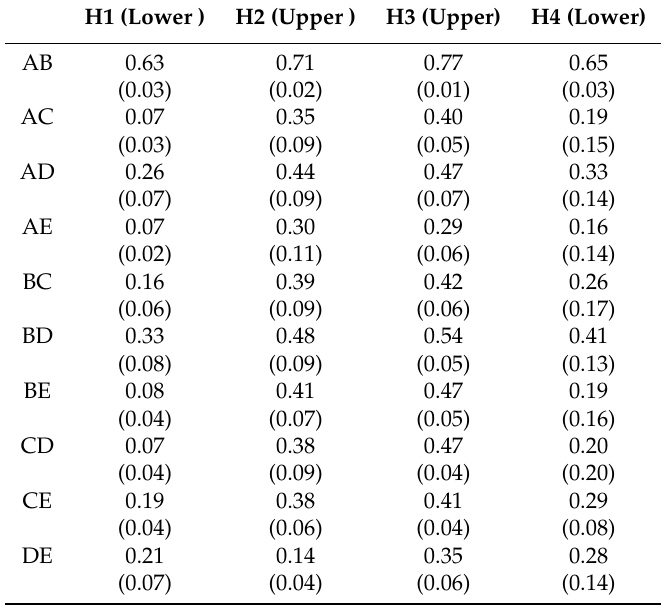
Table 5. Tail dependence induced by the model with conditioning to two